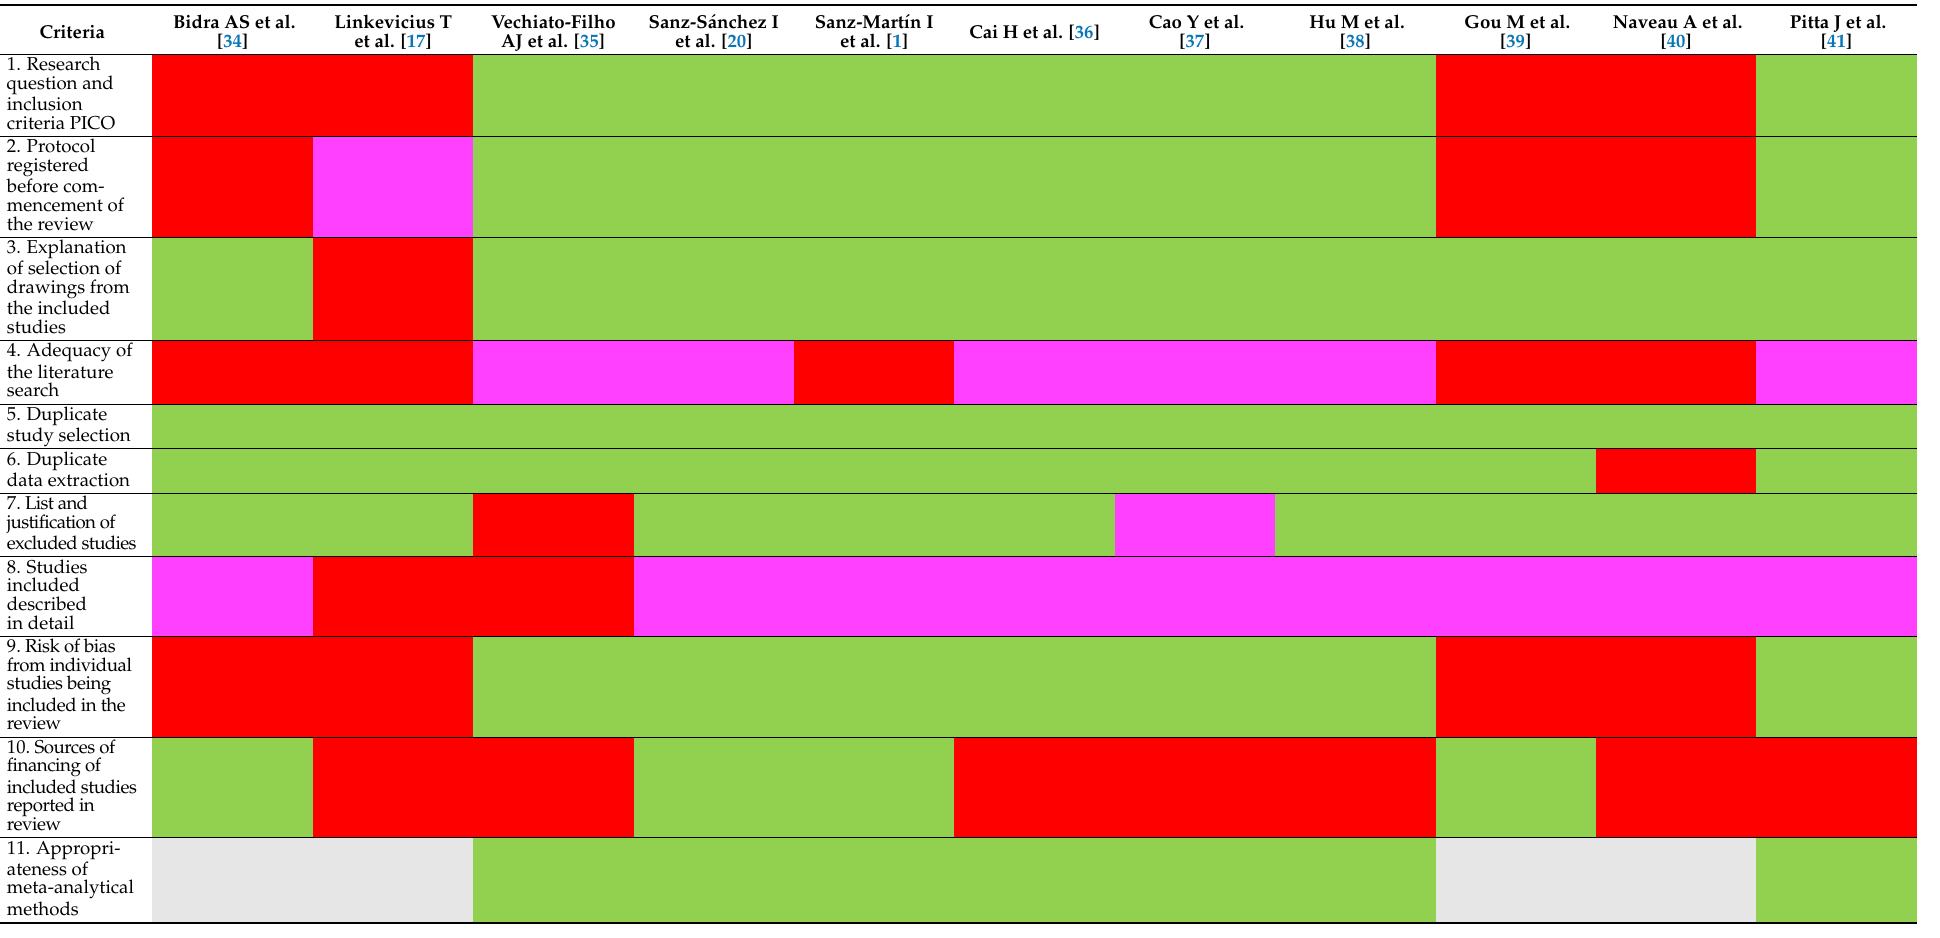
Table 3. Quality